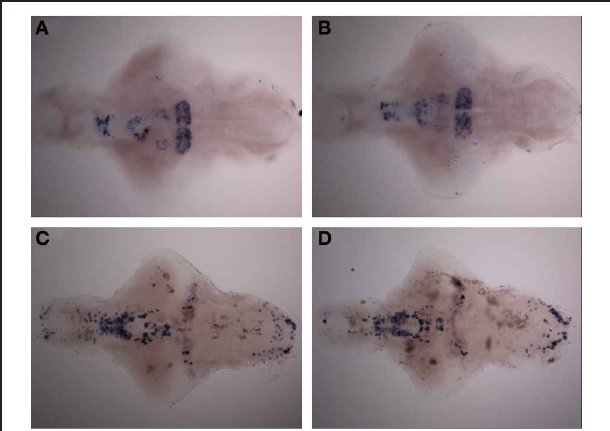
Frontiers in Neural